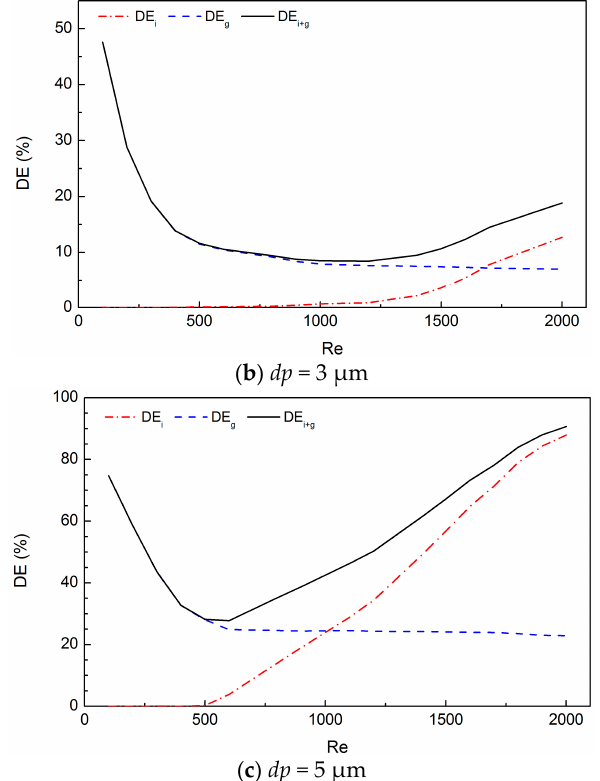
Figure 4. Particle deposition efficiency ( DE ) due to different mechanisms for three different particle diameters ( dp ).